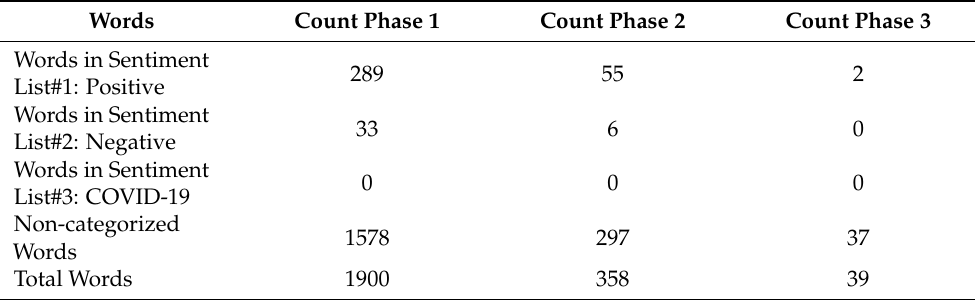
Table 4. Partition by NodeXL of Italian words used for analysis of the three